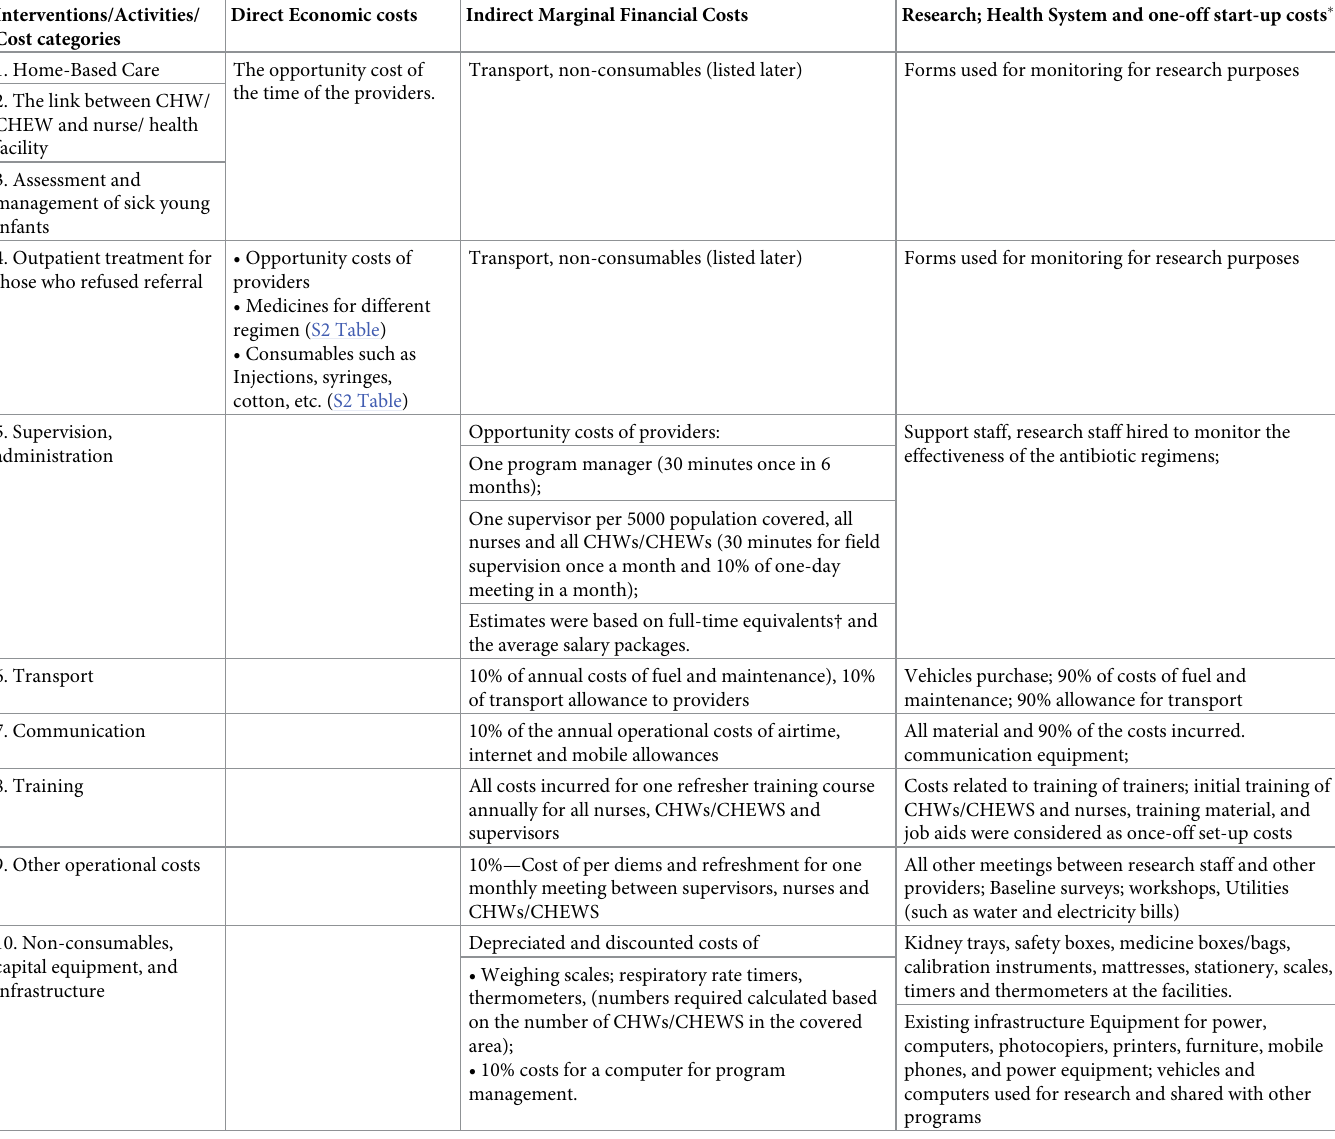
Table 1. Items included under direct costs, indirect costs and research/ health systems/ start-up costs for each activity. Interventions/Activities/ Cost